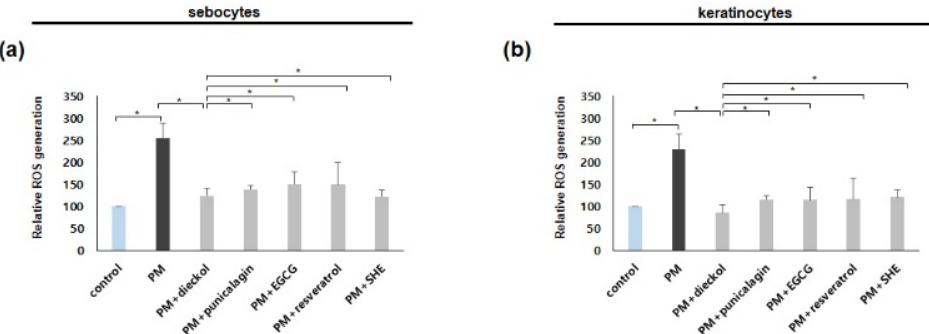
Figure 1. Preventative effects of antioxidants against the upregulation of ROS in the particulate matter <10 µ m (PM 10 )-treated sebocytes and ORS keratinocytes. An increase in the production of reactive oxygen species by PM 10 in cultured ( a ) sebocytes and ( b ) ORS keratinocytes was decreased by dieckol, punicalagin, epigallocatechin-3-gallate (EGCG), resveratrol, and Siegesbeckiae Herba extract (SHE). Data are represented as the mean ± SD from three independent experiments (* p < 0.05).